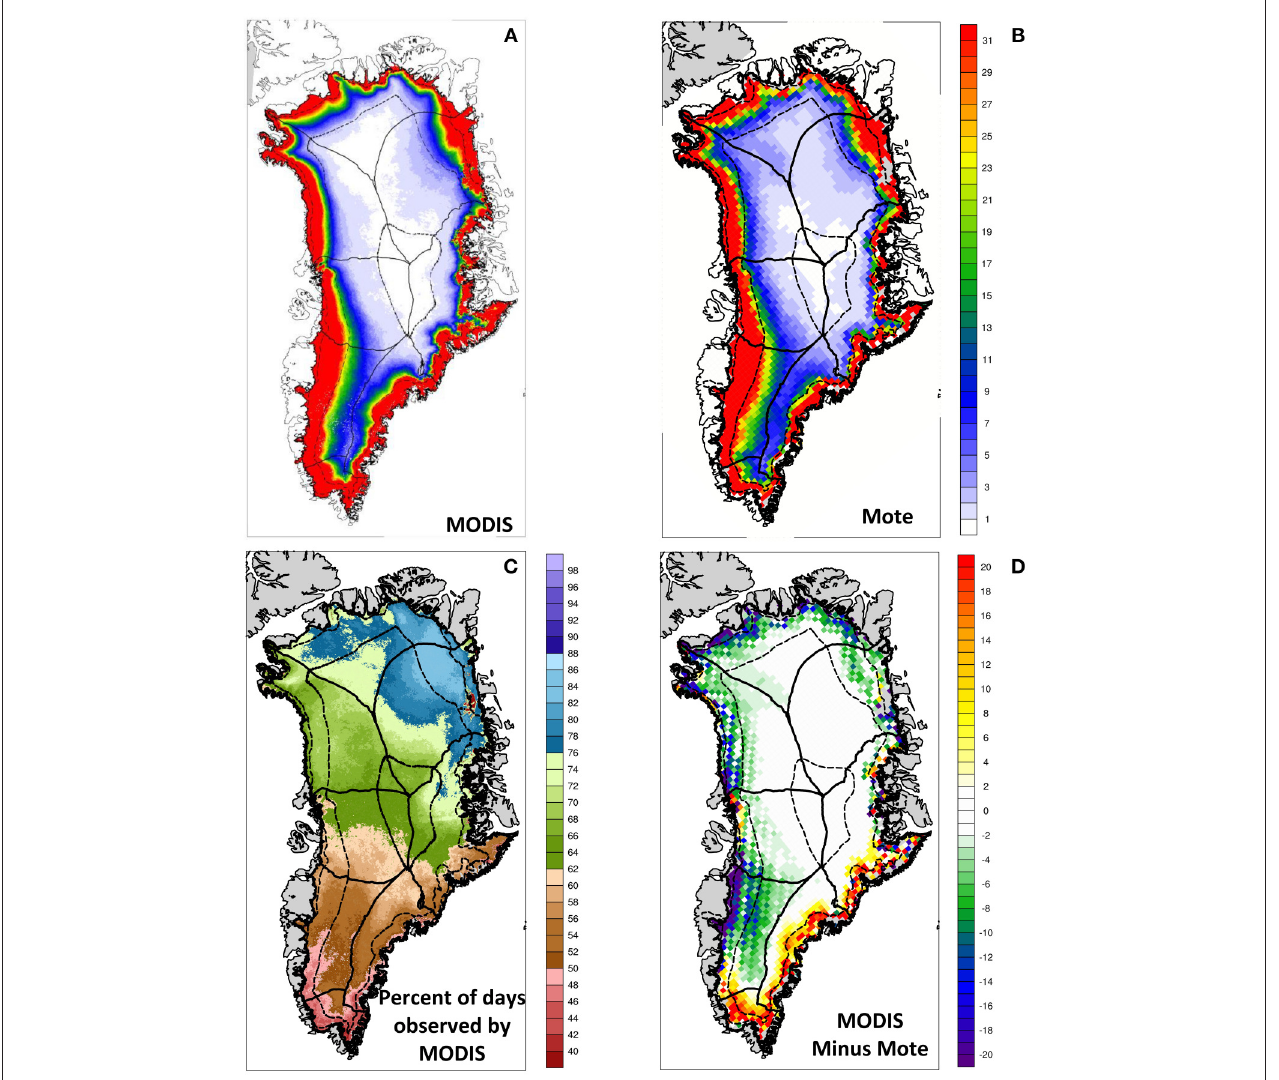
FIGURE 3 | Average number of GrIS melt days per year derived from (A) MODIS surface temperatures and (B) passive microwave data using the algorithm of Mote (2007) for 2000-2012. MODIS values were extrapolated based on the available number of observing days. (C) The percentage of days observed by MODIS. (D) Difference of the average number of melt days derived by MODIS minus passive microwave data using the Mote (2007) algorithm. Boundaries of major GrIS drainage basins of Zwally et al. (2012) are indicated, and surface orography from Bamber et al. (2001) is indicated with dashed contours for every 1000m of